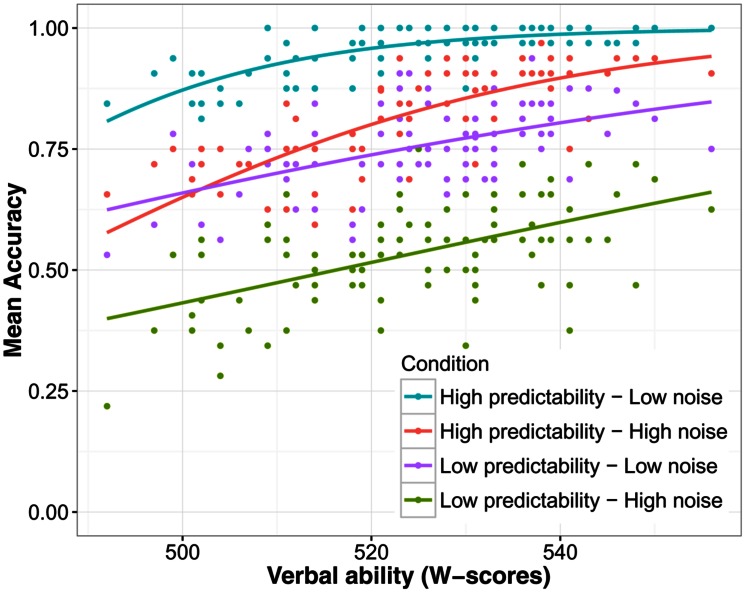
The effect of verbal ability on speech understanding in noise accuracy. W-scores are on an arbitrary equal-interval scale. Each dot in each condition represents one participant.